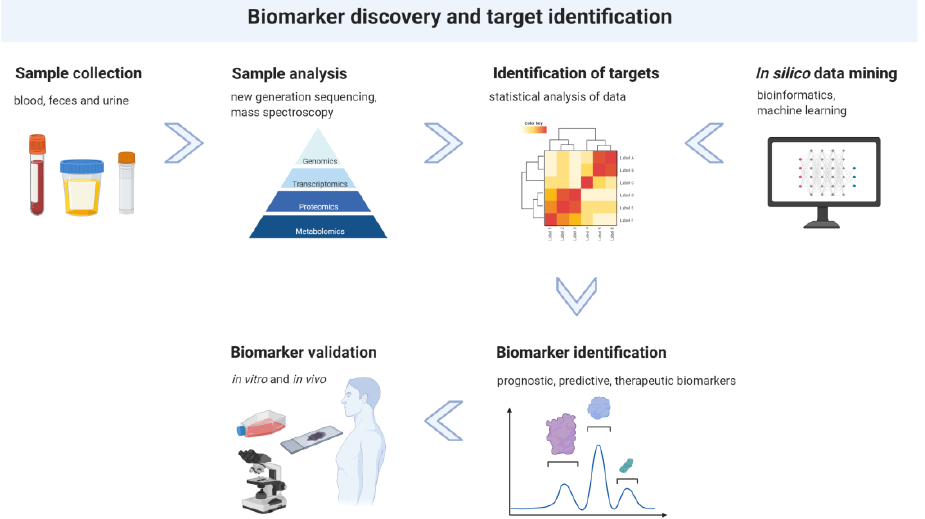
Figure 1. Schematic illustration of the pipeline and interaction of biomarker discovery and target identification. This figure was created with identification. This figure was created with BioRender.com.